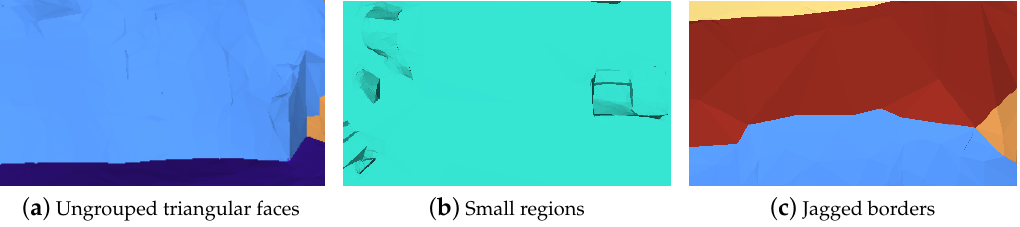
Figure 5. Optimized results of the examples in Figure 4. ( a ) Ungrouped triangular faces. ( b ) Small regions. ( c ) Jagged borders.